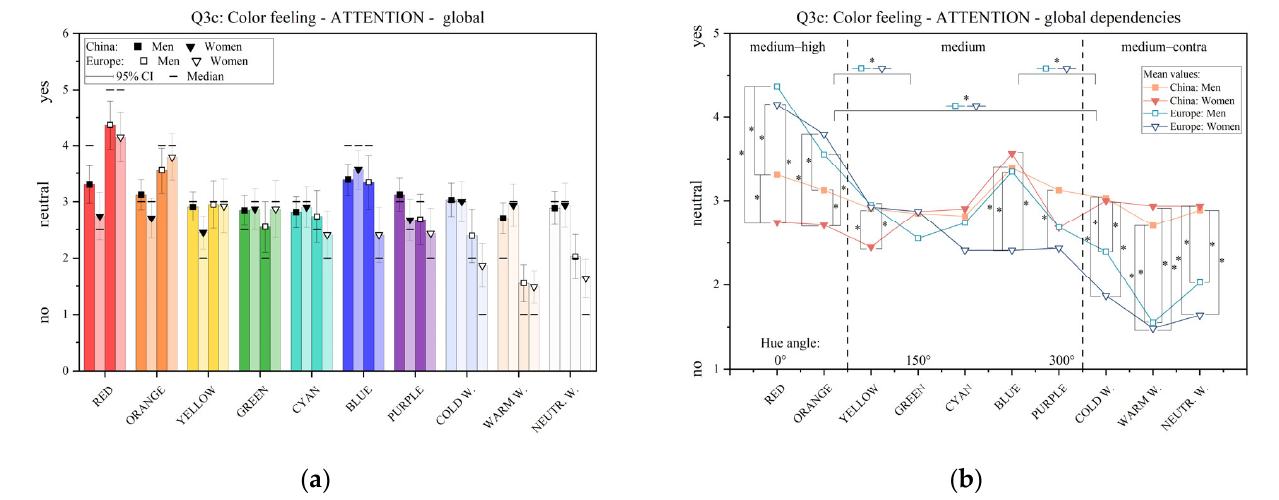
Figure 5. ( a ) Color-attention rating and ( b ) statistical evaluation separated between Chinese and European participants and genders. Statistical significances p < 0.05 marked with *.